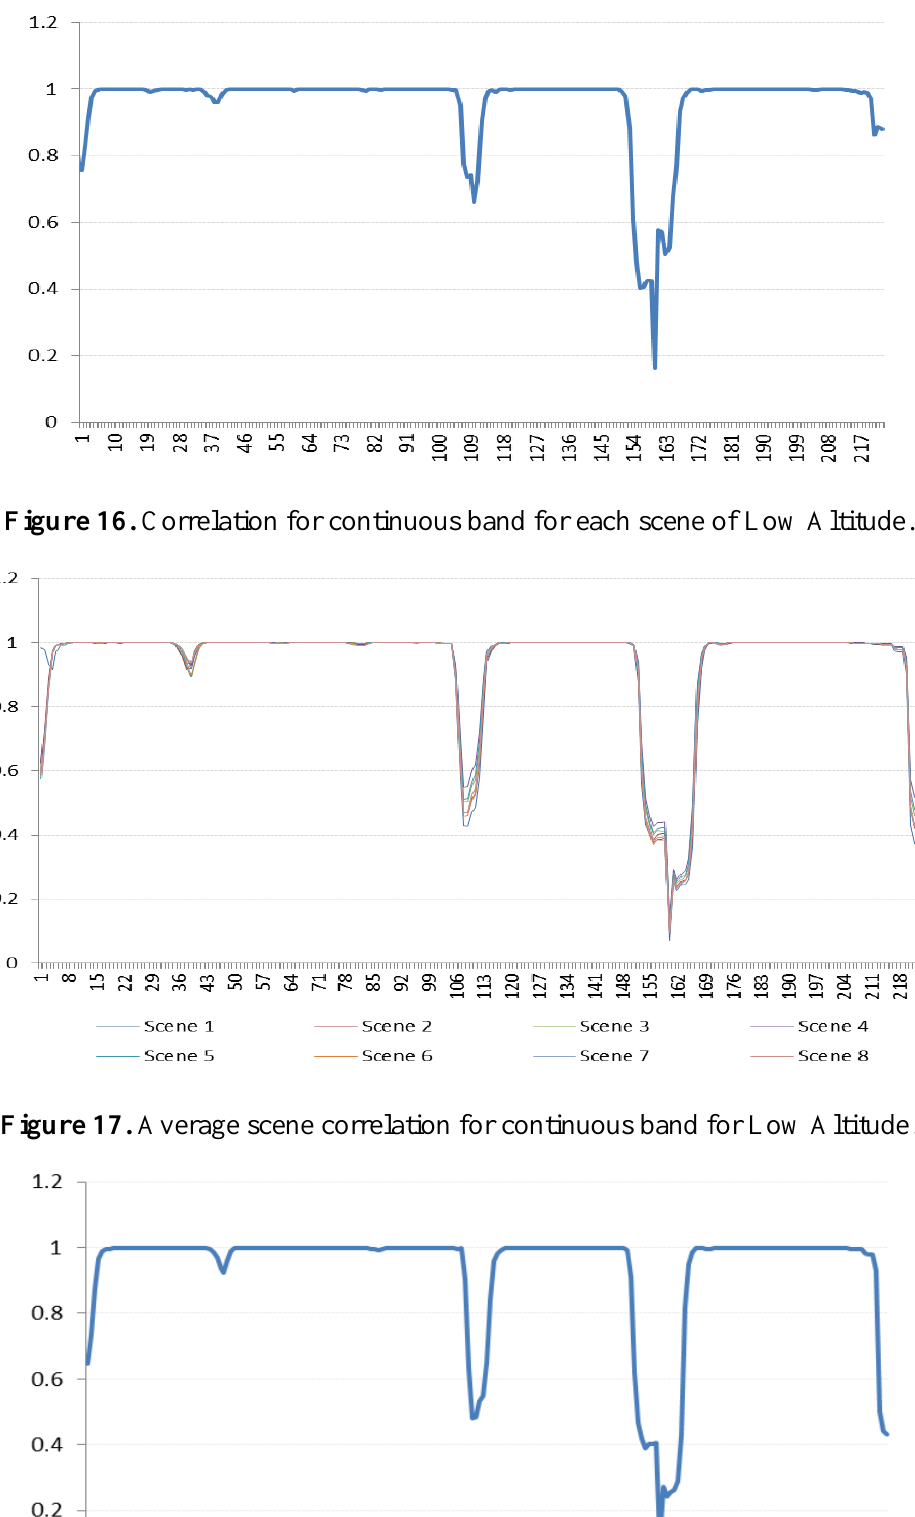
Figure 15. Average scene correlation for continuous band for Moffett Field.